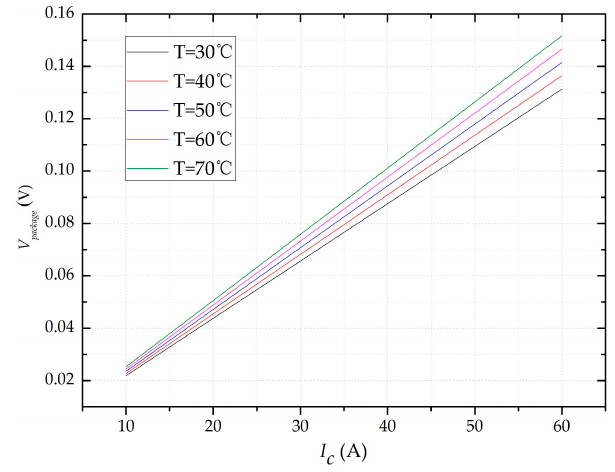
Figure 4. Package voltages at the different junction temperatures.